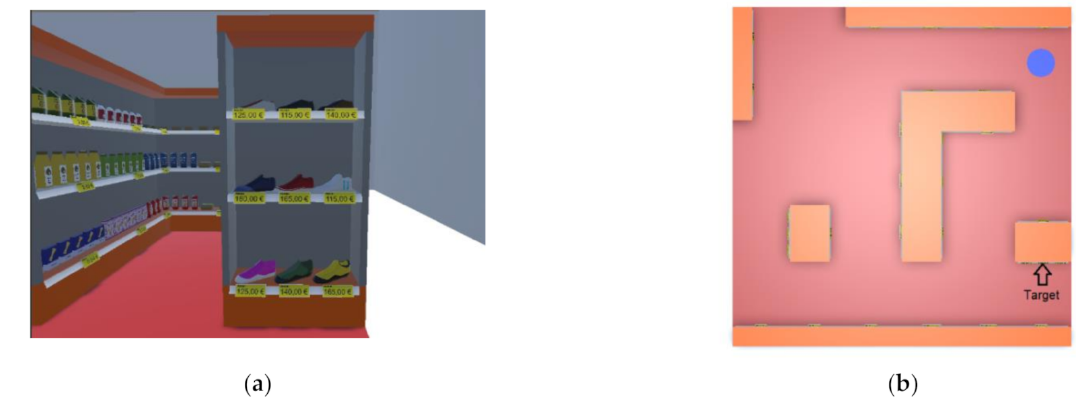
Figure 6. ( a ) The virtual shelf containing the sneakers, ( b ) the position of the target shelf in the virtual